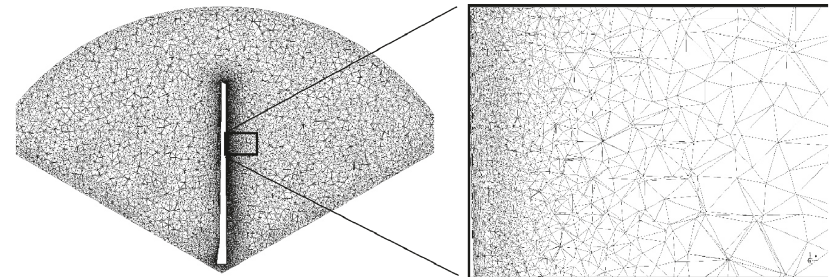
Figure 5: Wind turbine spatial discretization (mesh).